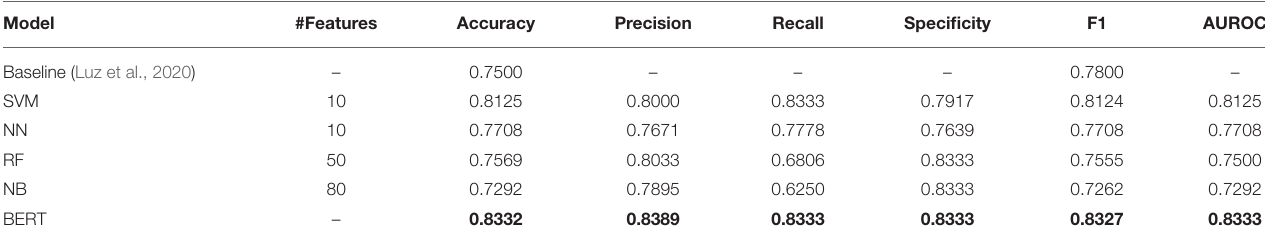
Bold indicates the best